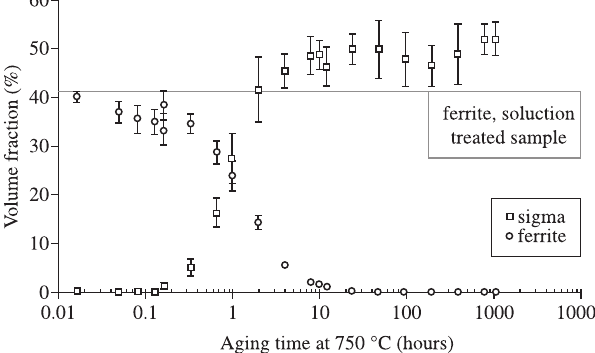
Figure 4. Ferrite and sigma phase content (vol. %) as a function of aging time at 750